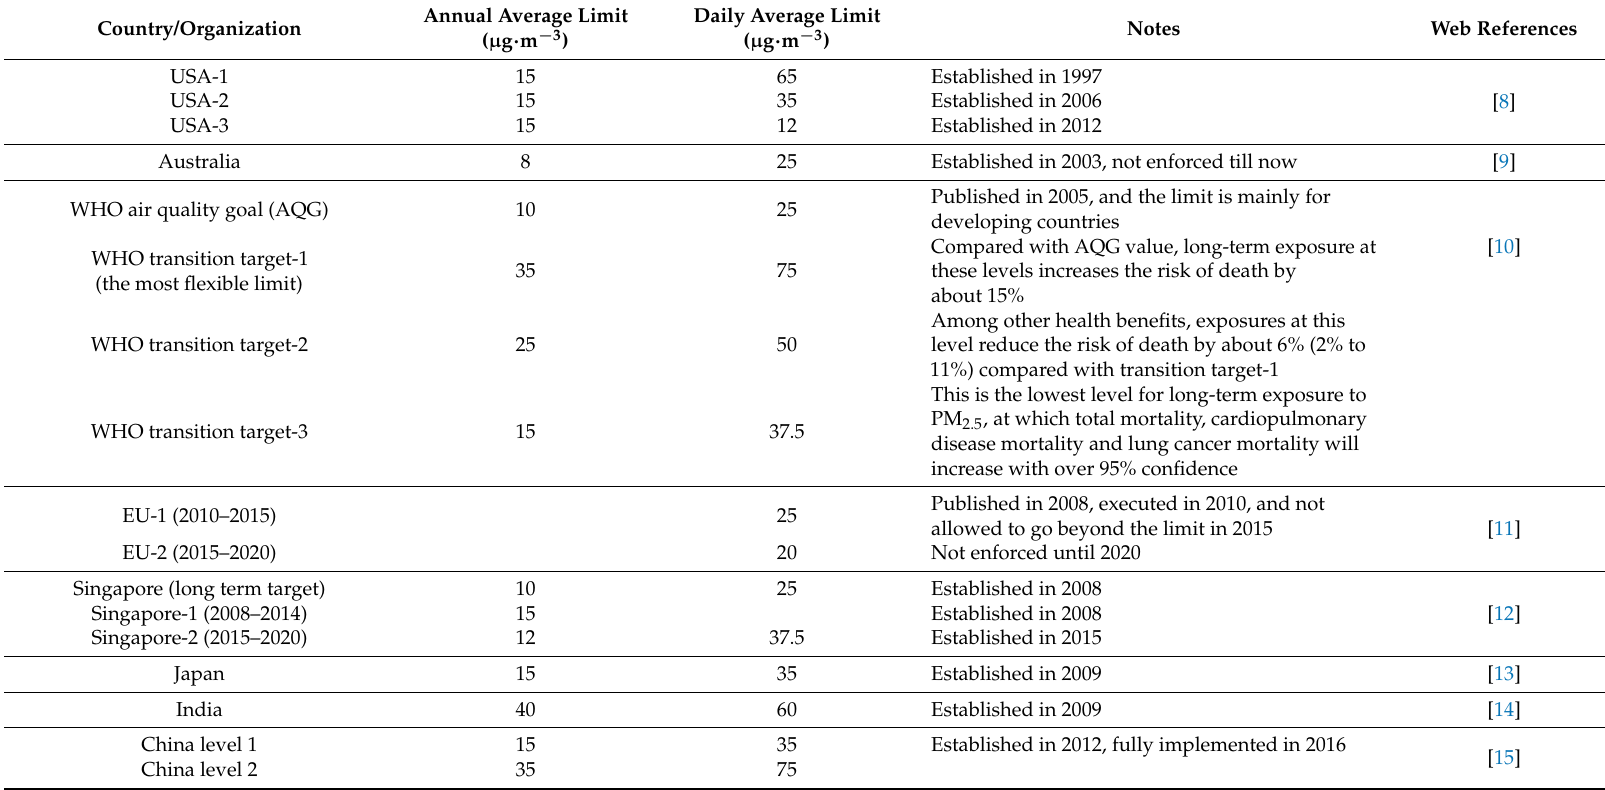
Table 1. Implementation time table for each country/organization on PM 2.5 concentration